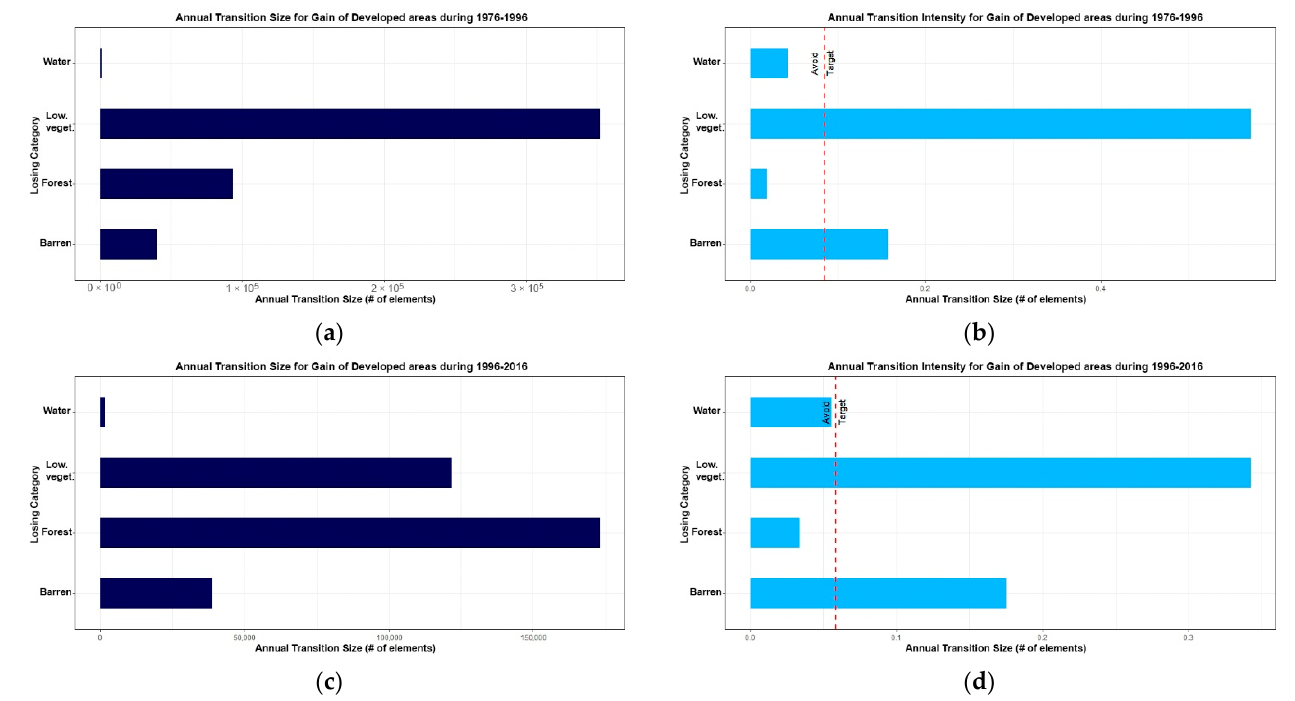
Figure 14. Annual gain transitions of developed areas class during 1976–1996 and 1996–2016; ( a ) annual transition size for gain of developed areas during 1976–1996; ( b ) annual transition intensity for gain of developed areas during 1976–1996; ( c ) annual transition size for gain of developed areas during 1996–2016; ( d ) annual transition intensity for gain of developed areas during 1996–2016.